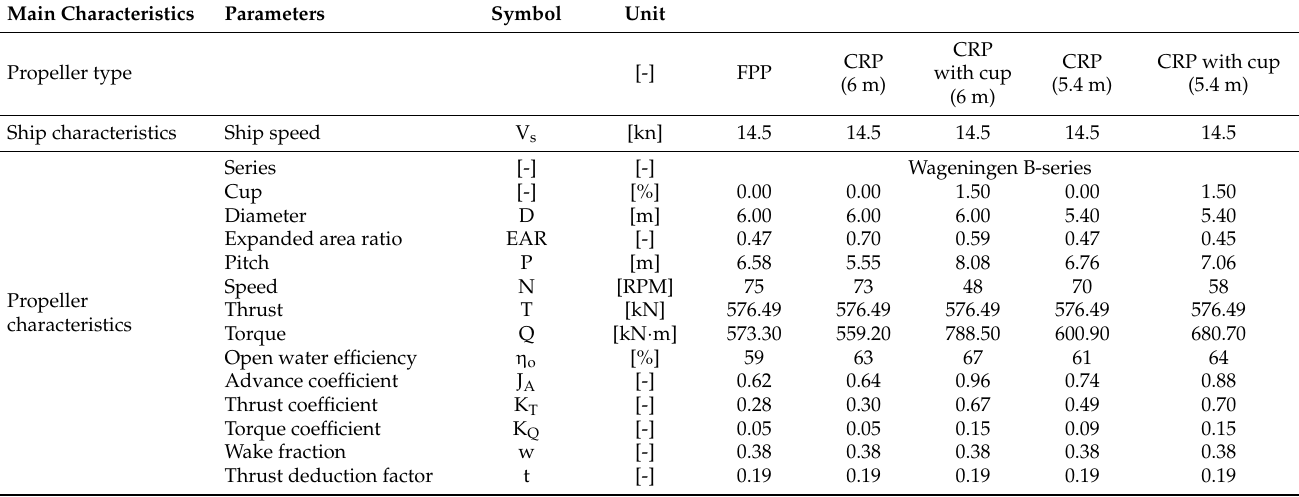
Table A1. Optimum results for different